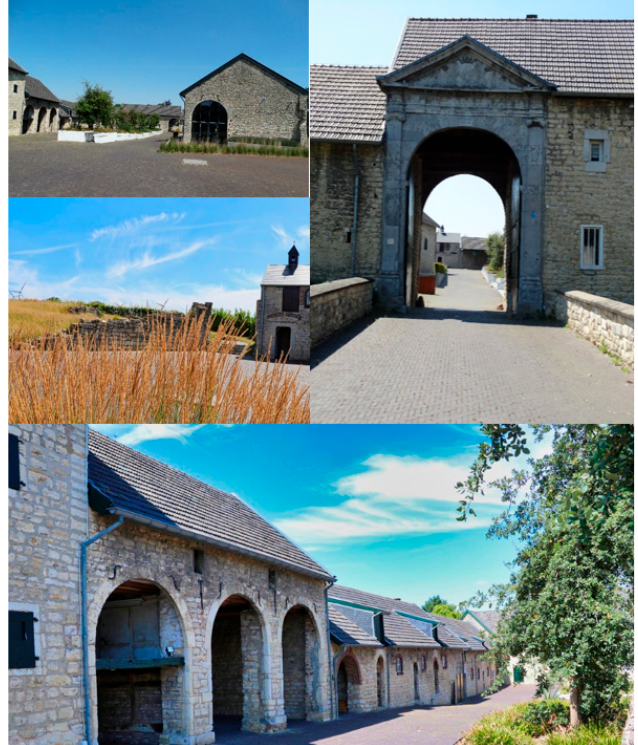
Figure 2. Illustrative images of the building in which the Homestead will be realized.